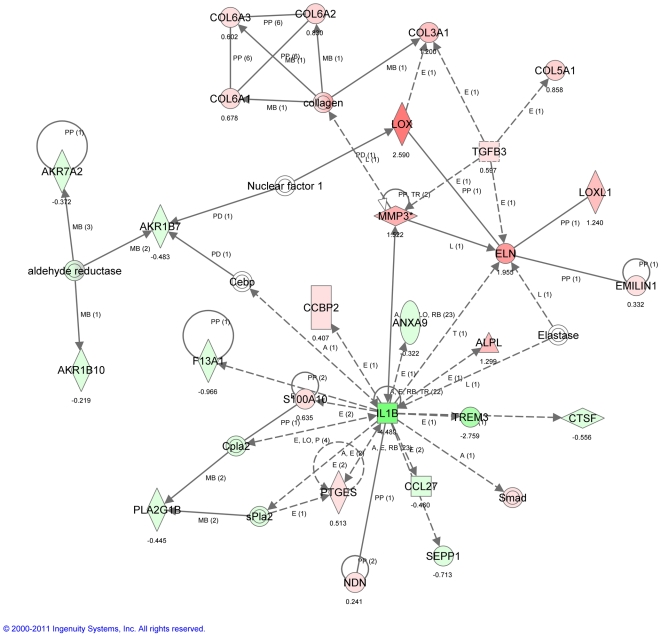
Ingenuity Pathway Analysis (IPA) of transcriptomic patterns 1 day after PNX.Top network illustrate transcripts that are significantly modulated in a whole lung analysis 1 day after PNX in 9 vs. 3 month mice. Green indicates down-regulated transcripts, red indicates up-regulated transcripts. Key: The node shapes denote - enzymes  phosphatases  kinases  peptidases  G-protein coupled receptors  transmembrane receptors  cytokines  growth factors  ion channels  transporter  transcription factor  other .